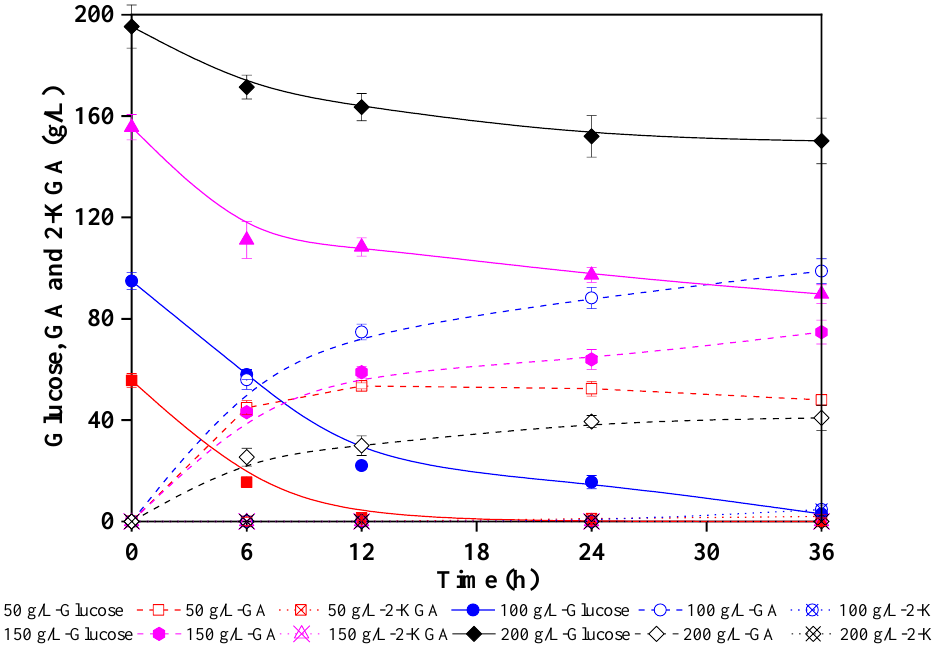
Figure 4. Comparison of GA (gluconic acid) and 2-KGA (2-ketogluconic acid) production perfor- mance of Gluconobacter oxydans in corncob enzymatic hydrolysates with different concentrations. However, the glucose catalysis ability of G. oxydans declined significantly in 150 g/L and 200 g/L corncob enzymatic hydrolysate, yielding only 74.7 g/L and 40.9 g/L GA at 36